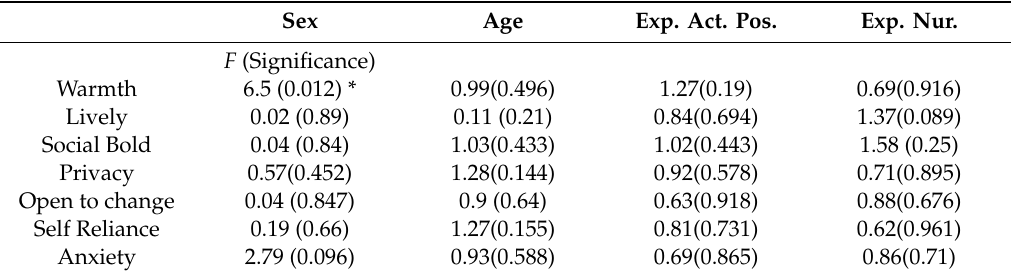
Table 3. Relationship between socio-demographic variables, empathy components, and anxiety.